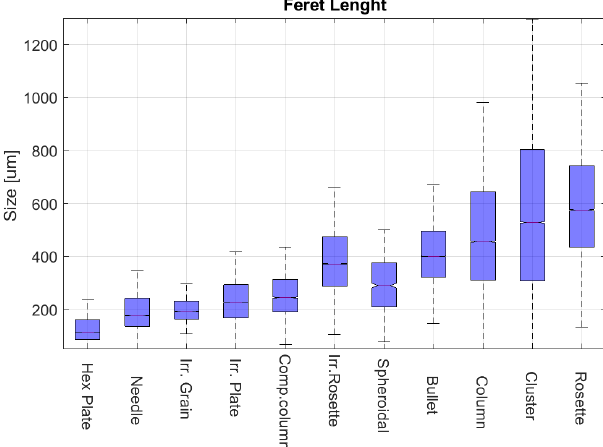
Figure 21. Feret length statistics for the years